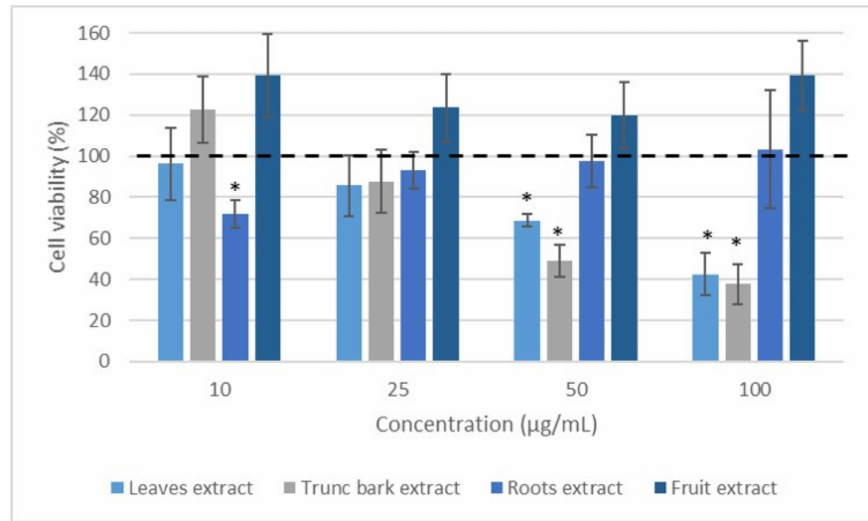
Figure 8. Effect of Crossopteryx febrifuga extracts on leukocyte viability. Blood cells were treated with the indicated concentrations of extracts, in the presence of PMA for 24 h. Data were shown as means ± SEM (Control = 100%), * p < 0.05 compared with